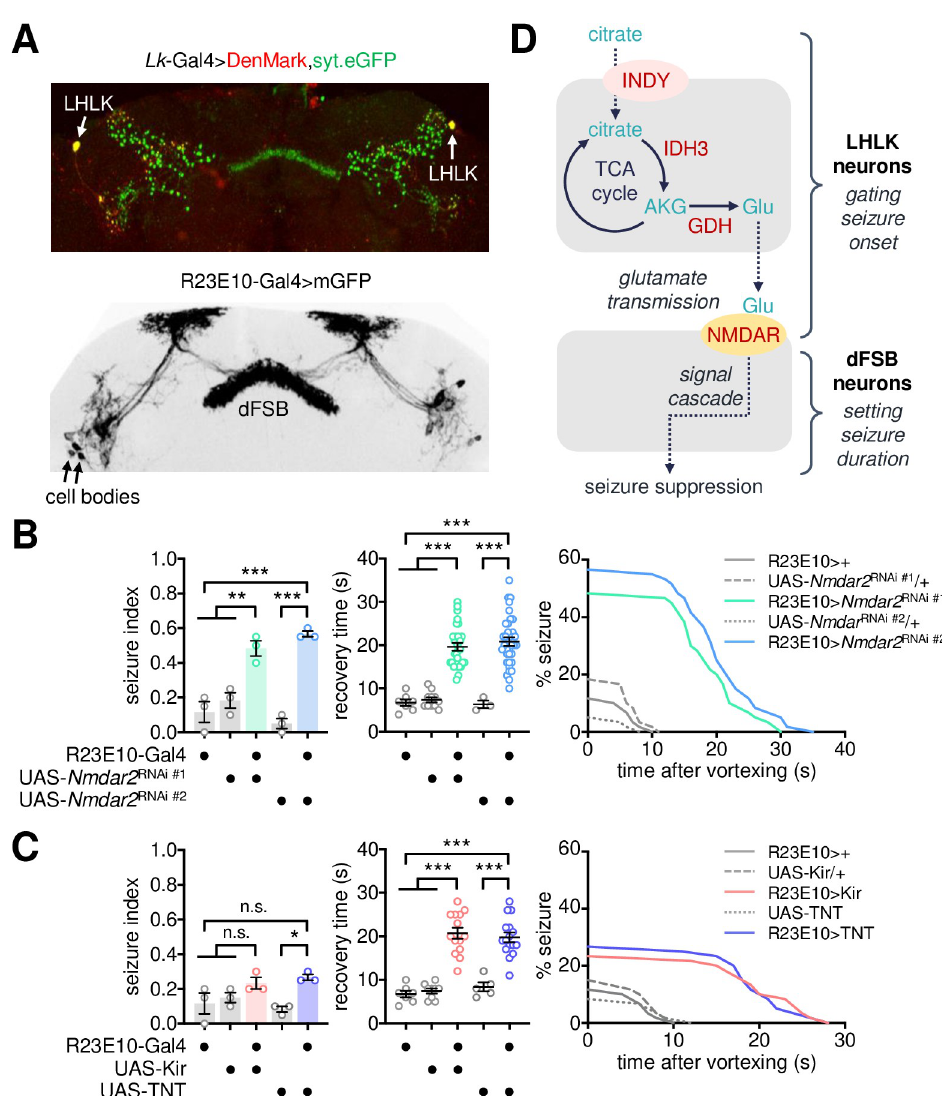
Fig 7. NMDA receptors in dorsal fan-shaped body neurons relay seizure-suppressing glutamate transmission. (A) Representative confocal images of dendrites (DenMark, red) and axonal projections (syt.eGFP, green) from LHLK neurons (top) and mGFP expression from dFSB-specific R23E10-Gal4 driver (bottom) in the adult fly brain. (B) Depletion of NMDA receptors in dFSB neurons induces BSS. Quantitative analyses of BSS in individual flies were performed as described in Fig 1. Data represent means ± SEM. �� P < 0.01, ��� P < 0.001, as determined by one-way ANOVA with Holm-Sidak’s multiple comparisons test (seizure index, n = 60 in 3 independent experiments) or by Welch’s ANOVA with Dunnett’s multiple comparisons test (recovery time, n = 3–34). (C) Genetic silencing of dFSB neurons lengthens recovery time after BSS. Data represent means ± SEM. n.s., not significant; � P < 0.05, ��� P < 0.001, as determined by one-way ANOVA with Holm-Sidak’s multiple comparisons test (seizure index, n = 60 in 3 independent experiments; recovery time, n = 5–16 for TNT) or by Welch’s ANOVA with Dunnett’s multiple comparisons test (recovery time, n = 7–14 for Kir). (D) A working model for the neurometabolic pathway of Indy - dependent seizure